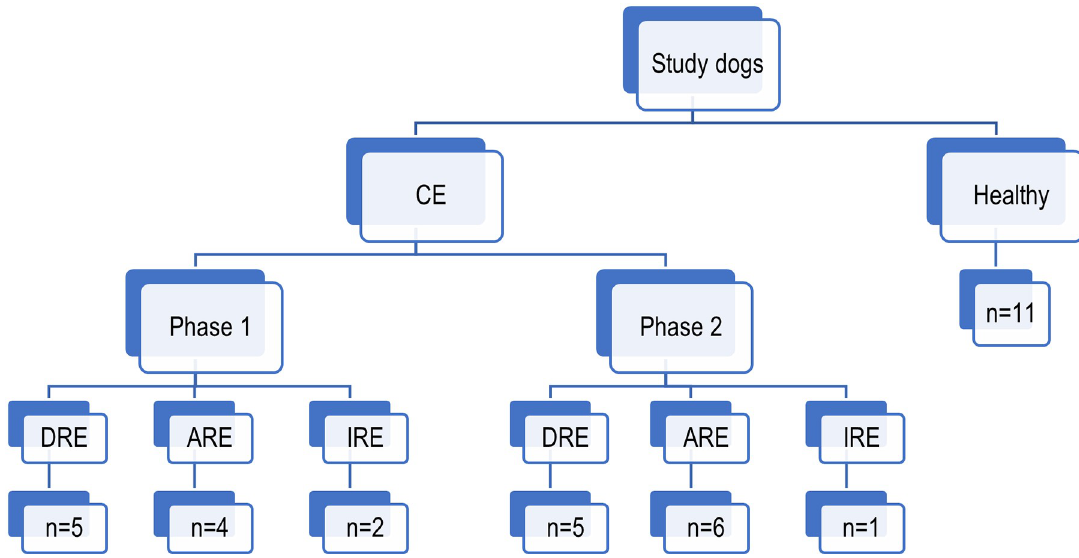
Fig 1. Breakdown of the study dog population. CE: Chronic enteropathy. DRE: Diet-responsive enteropathy; ARE: Antibiotic- responsive enteropathy and IRE: Immunosuppressant-responsive enteropathy.